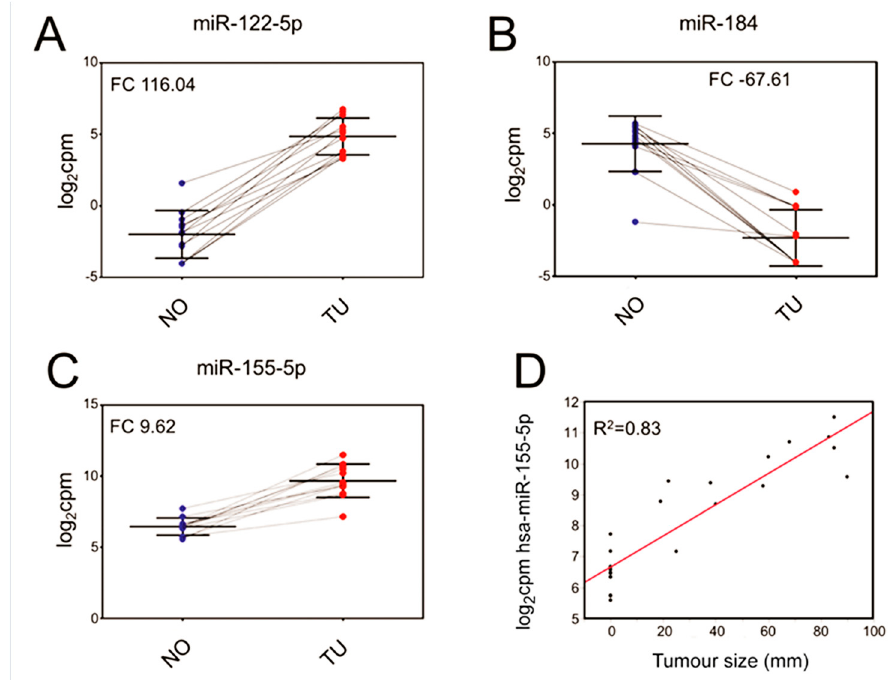
Figure 2. ( A ) Scatterplots of the expression of miR-122-5p (adj. p -value 4.68× 10 − 8 ); ( B ) miR-184 (adj. p -value 2.05 × 10 − 6 ) and ( C ) miR-155-5p (adj. p -value 1.86× 10 − 6 ) to classify samples as either tumour (TU, in red) or normal (NO, in blue). Each dot represents the result from one sample. Normal and tumour samples originating from the same donor are connected by lines; ( D ) displays the correlation of miR-155-5p expression and tumour size, which results in a linear regression with R 2 = 0.83.